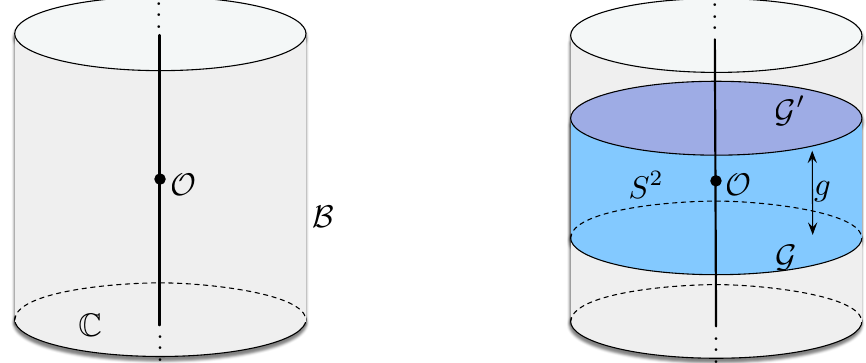
at in(cid:12)nity, reinterpreted B